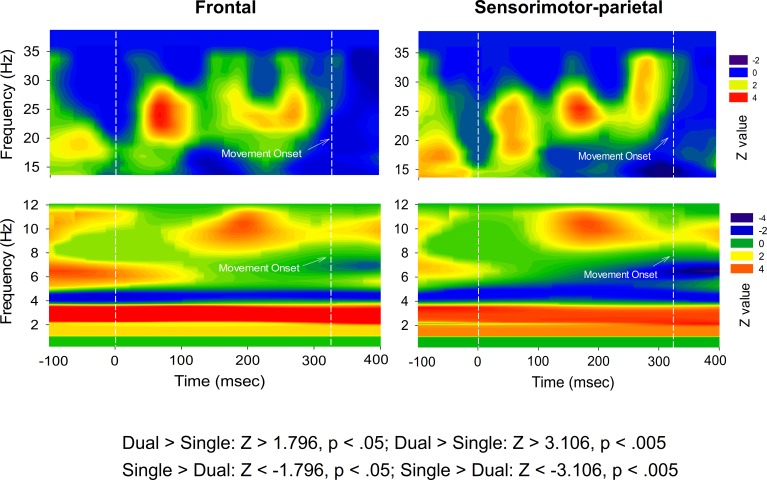
Normalized task-related differences in time-frequency distribution for the PC1 in terms of Z values.The dual-task condition exhibited 1) a greater persistent delta oscillation in the frontal and sensorimotor-parietal areas; 2) persistent suppression of theta oscillation in the frontal and sensorimotor-parietal areas; and 3) a more pronounced beta (13–35 Hz) synchronization around 100 ms and 200 ms after the executive signals. (Although only the dual-task condition has movement onset value for the force-matching task, we also labelled the lines in the Figs of the single-posture condition for the ease of comparison with those of the dual-task condition).